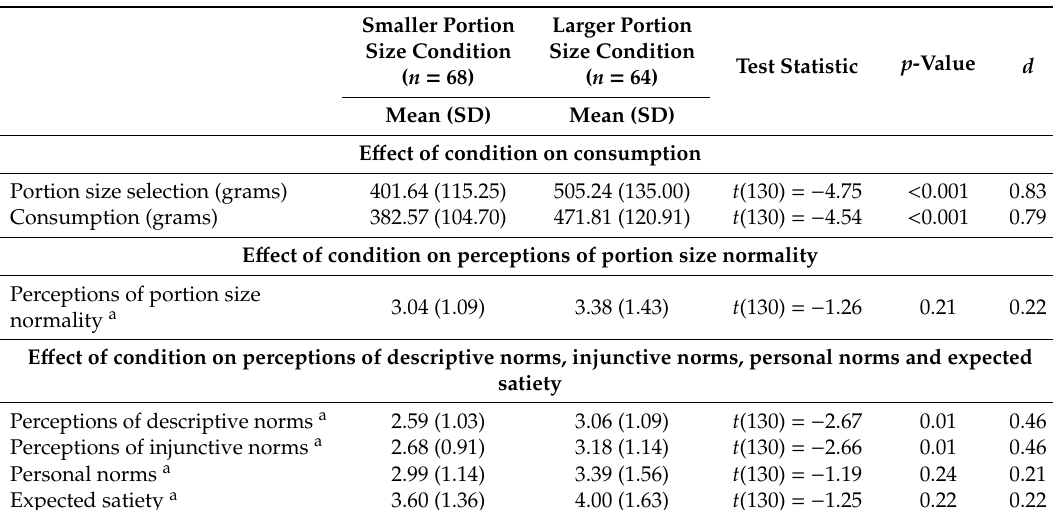
Table 5. Portion size selection, consumption and portion size evaluations per condition on day